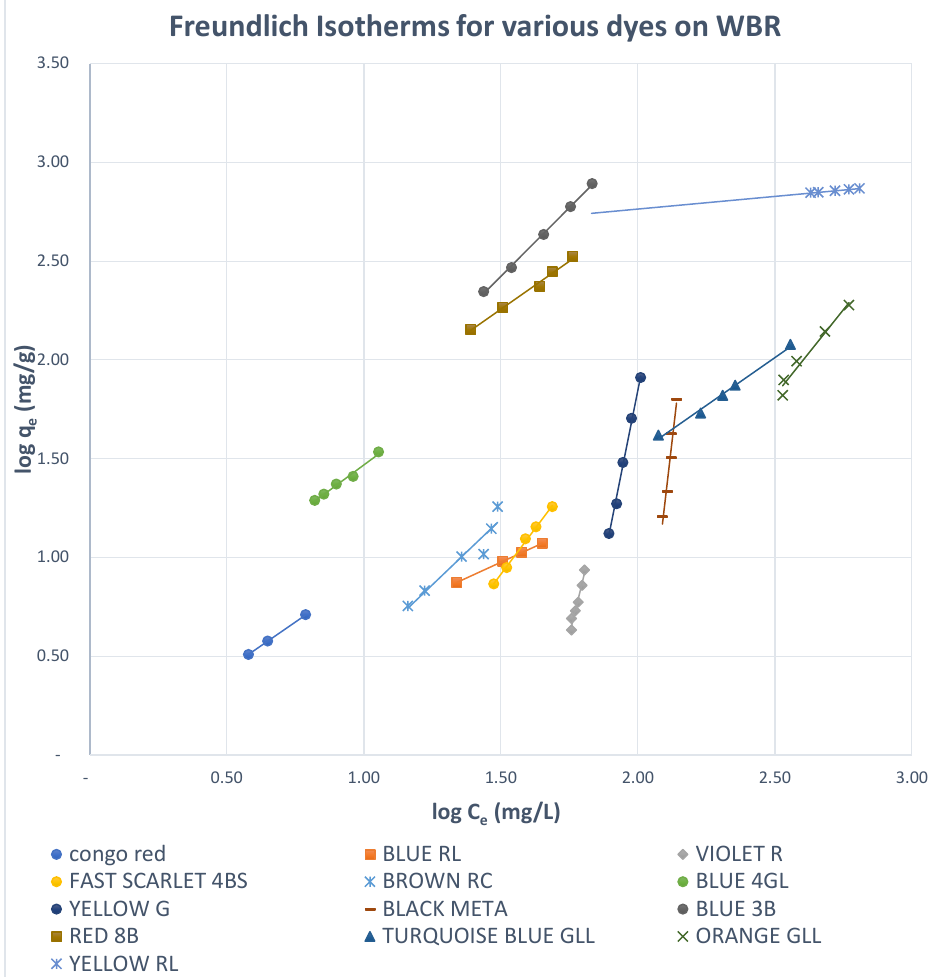
Figure 11. Freundlich isotherms for various dyes on WBR.